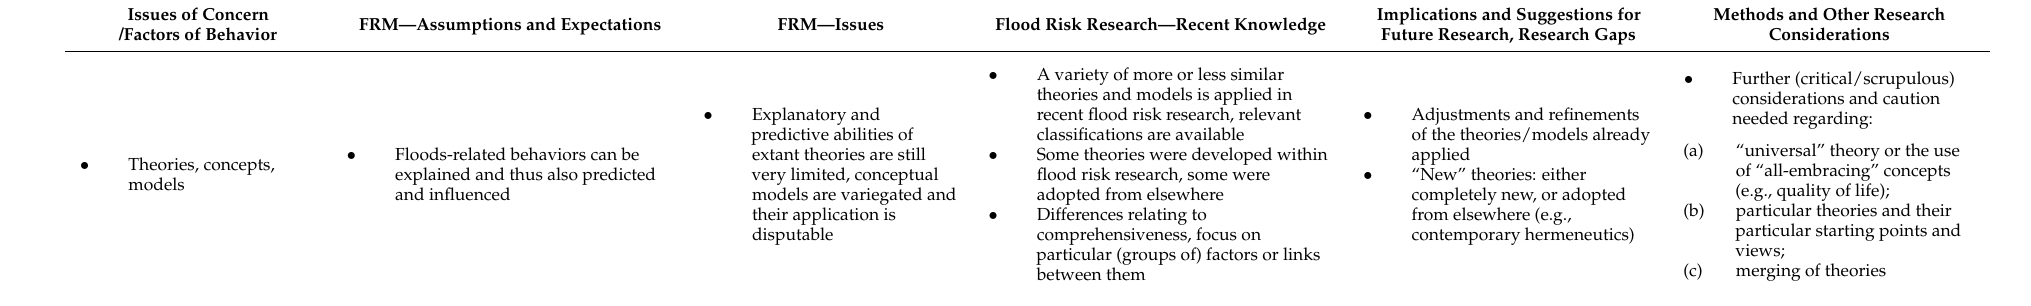
Table 8. Theories, conceptual frameworks/models—overview of findings, implications, and suggestions for future flood risk research